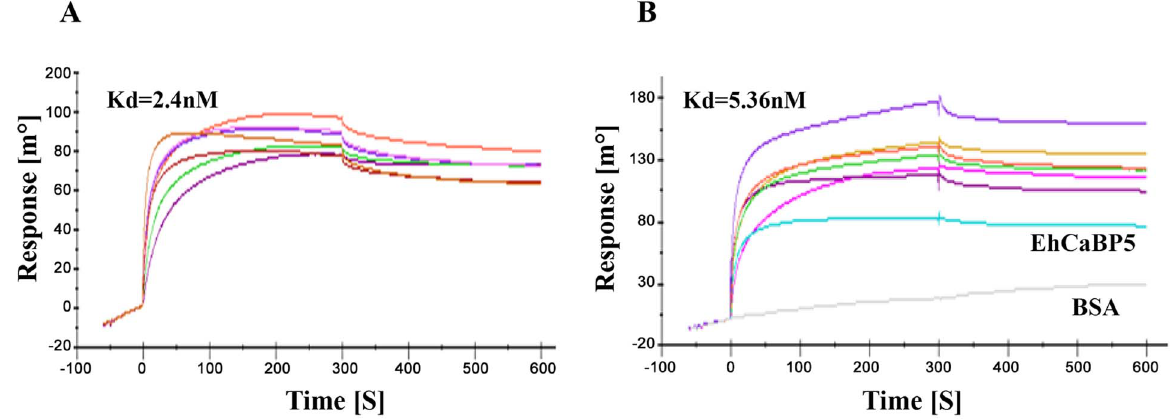
Fig 3. Binding of EhCaBP5 with IQ motif. SPR Sensograms representing interaction between myosin 1B IQ motif peptide (IQKAWKGYRNRKR) and EhCaBP5 in presence of Ca 2 + (3A) and absence of Ca 2 + (presence of 5 mM EGTA) (3B). Different concentrations of CaBP5 were injected onto the sensor chip to calculate the dissociation constant (Kd). BSA was also injected at concentration 750 nM (Fig. 3B, grey colour).